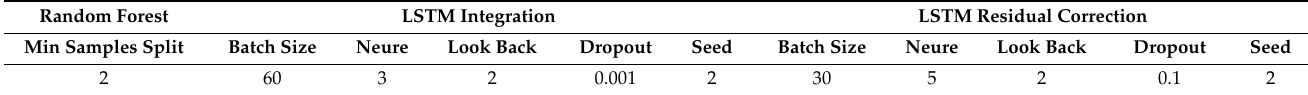
Table 5. Parameters used in case